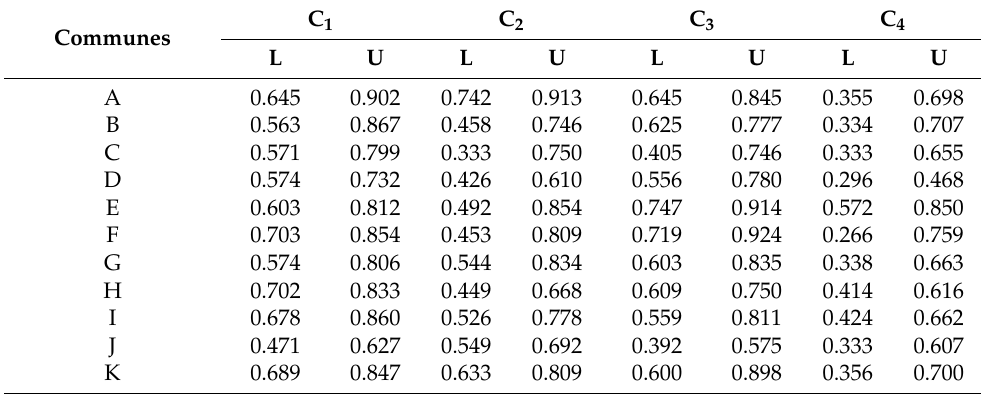
Table 5. Degrees of membership in the form of intervals for criteria C 1 –C 4